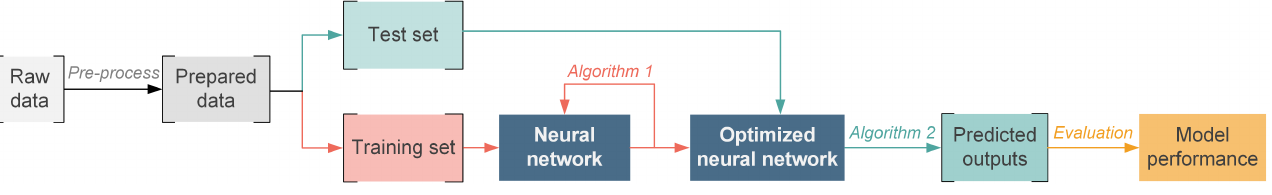
Figure 6. The workflow of the experiment